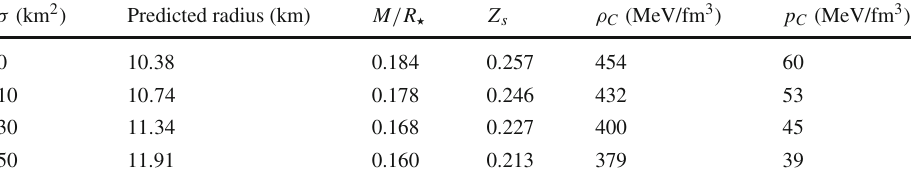
Table 3 Physical parameters of the strange star candidate LMC X-4 for different values of σ and B = 60 MeV/fm